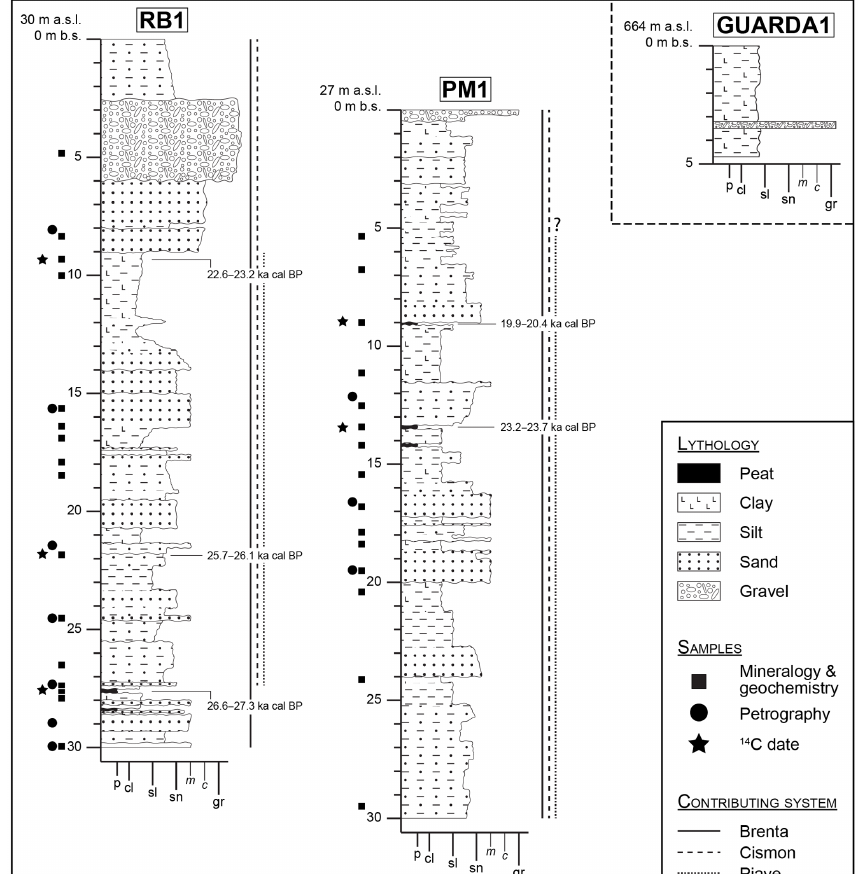
Figure 6. Stratigraphic logs of the RB1, PM1 and Guarda1 cores. Different catchments contributing to the sedimentation are marked by lateral solid/dashed lines. Samples are shown using different symbols according to the technique that was